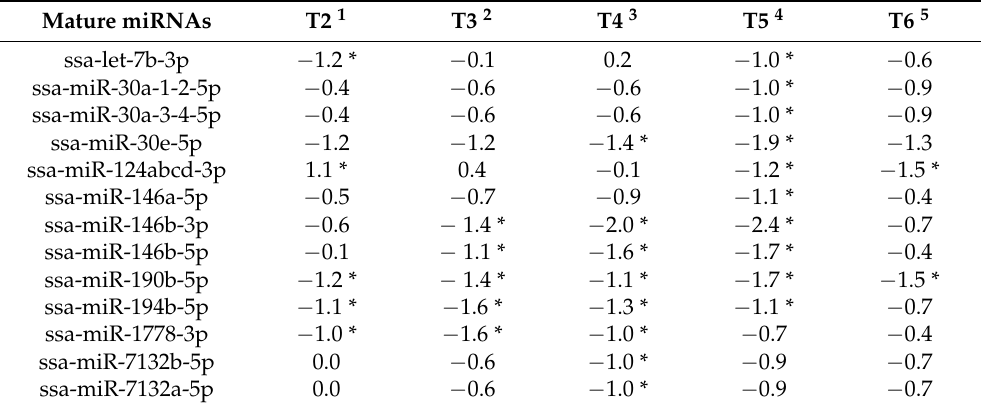
Table 1. Expression changes of gDE miRNAs in cluster 1.